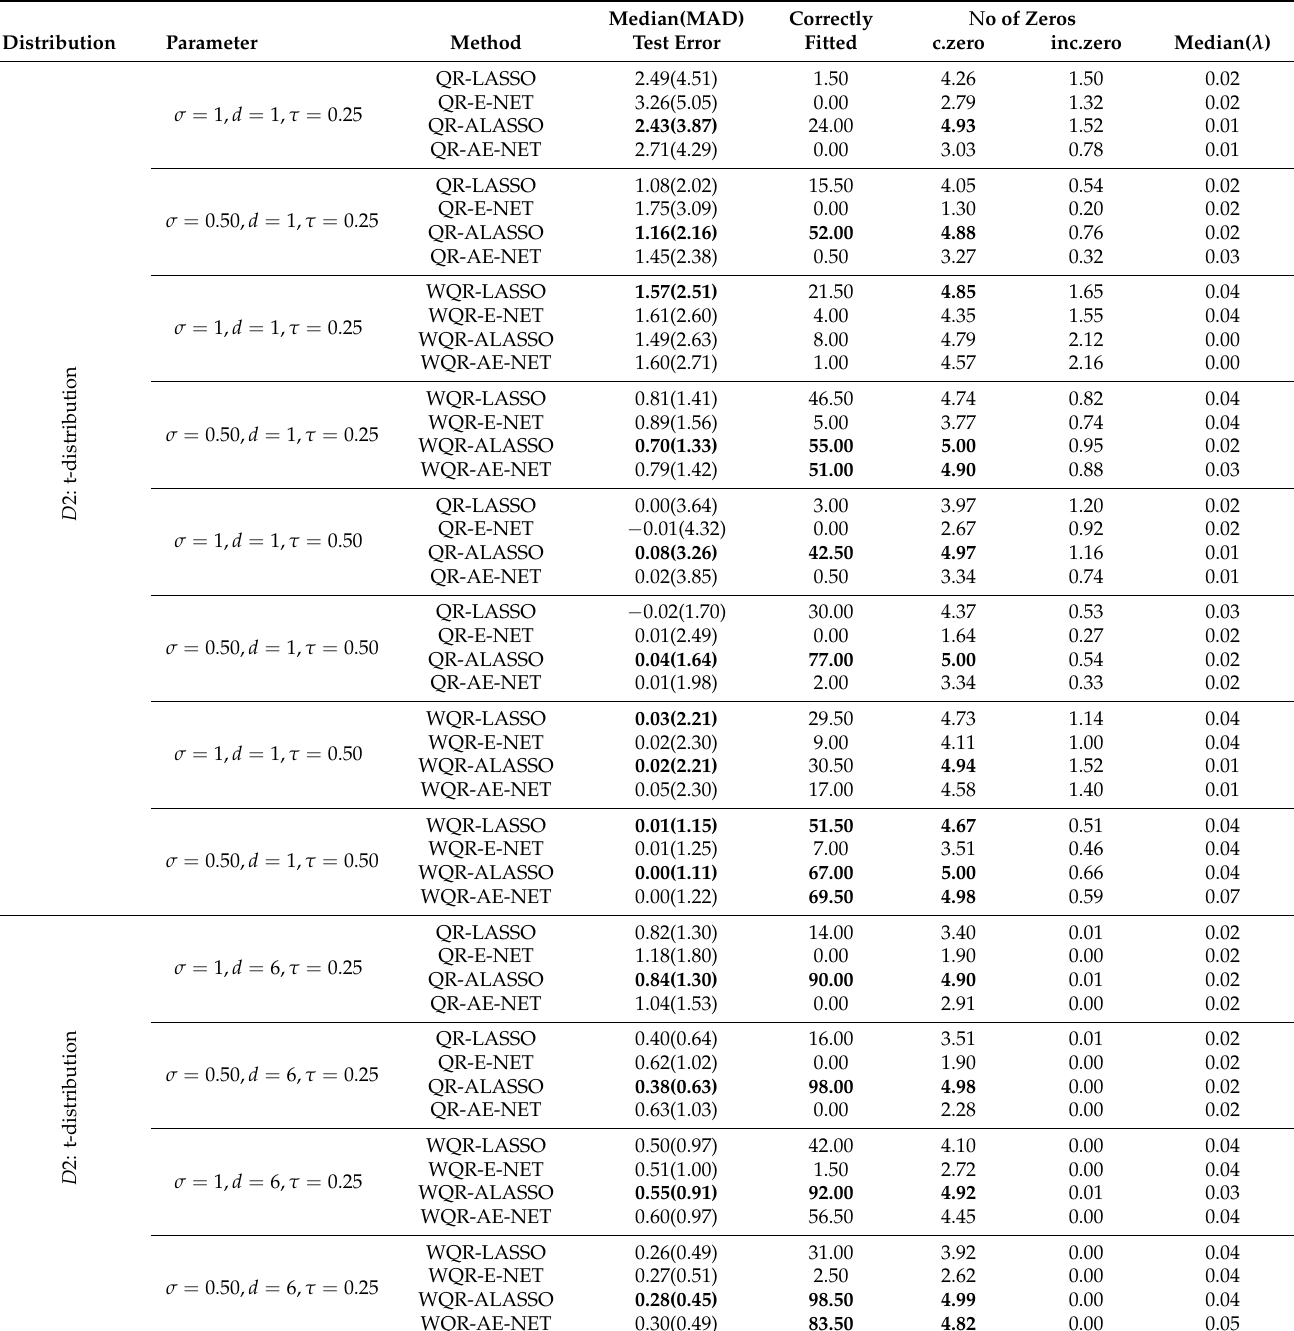
Table 4. Penalized weighted and unweighted quantile regression at D 2 for n = 50 ( τ = 0.25 and τ = 0.50) under the heavy tailed